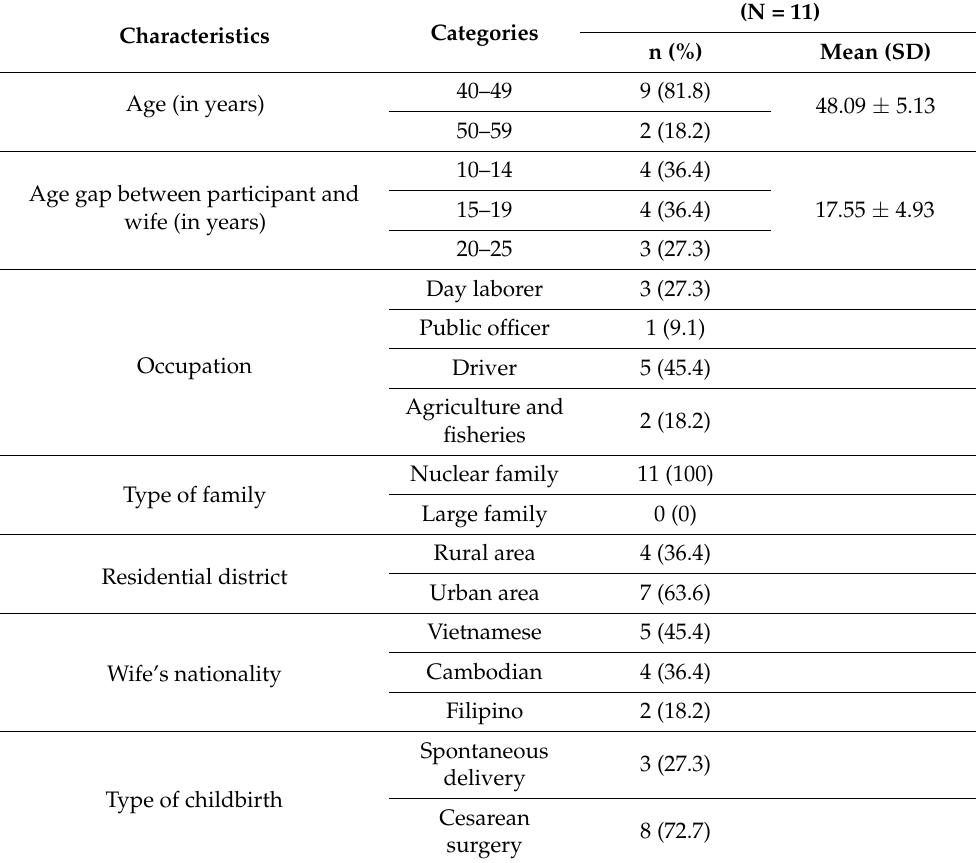
Table 1. General Characteristics of